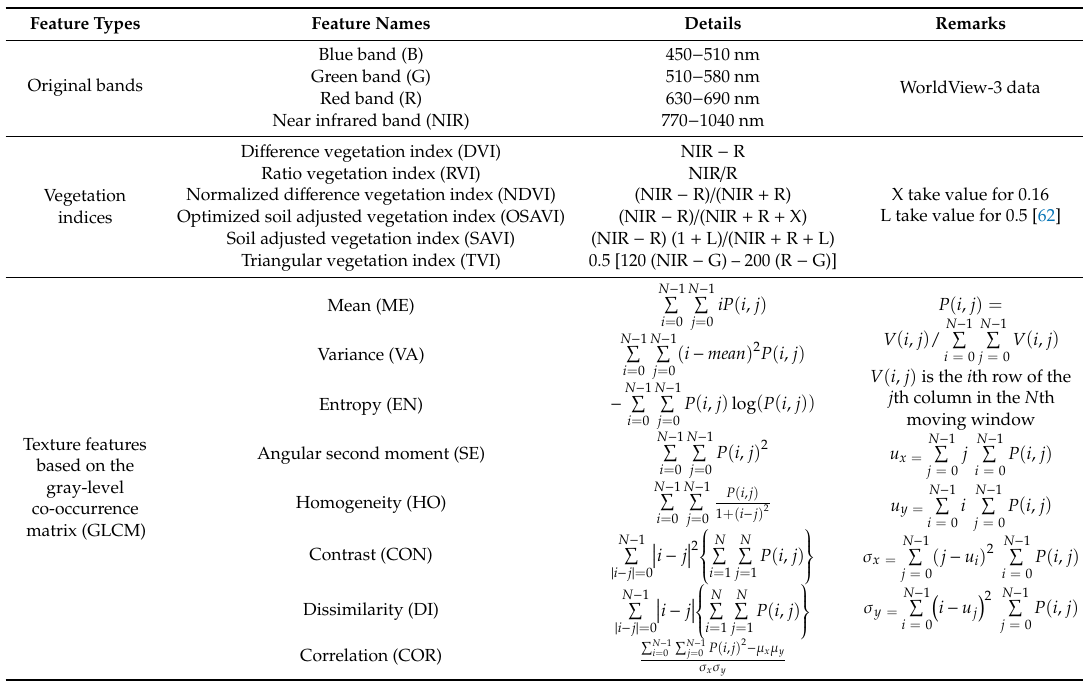
Table 2. All the involved features are listed in detail in this paper, including original bands of WorldView-3 data, vegetation indices, and texture features based on the gray-level co-occurrence matrix